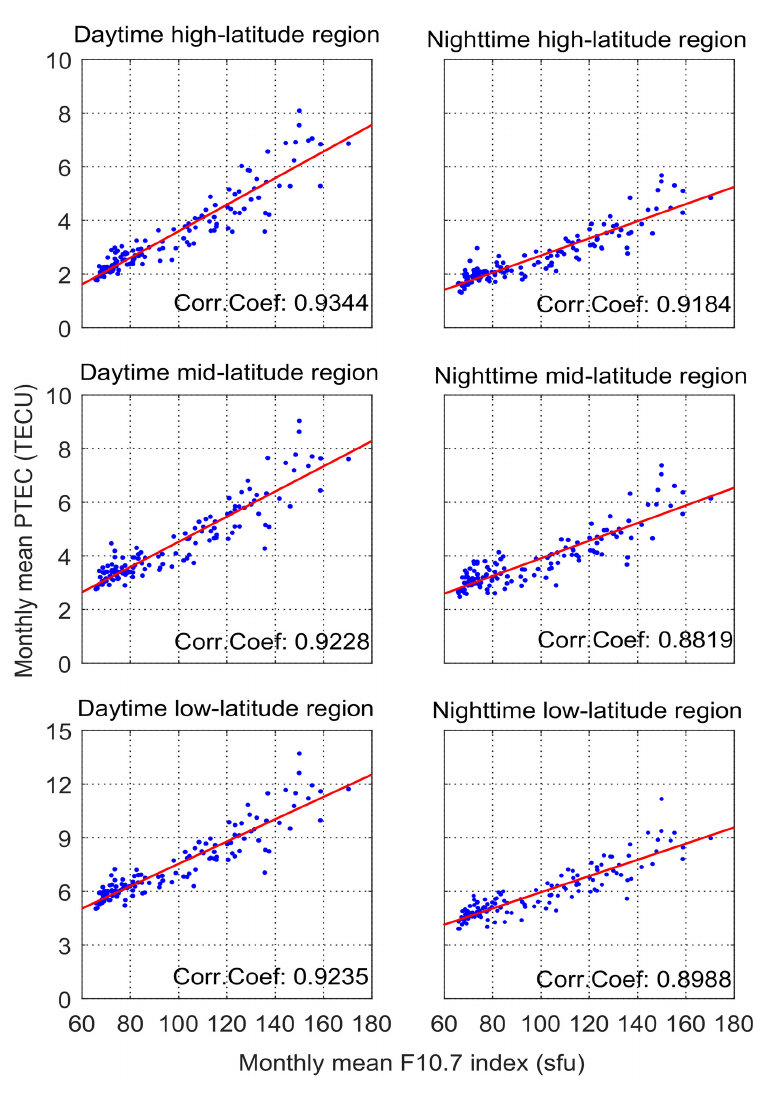
Figure 13. Correlations between monthly mean F10.7 index and monthly mean daytime and nighttime PTEC in different geomagnetic latitude regions